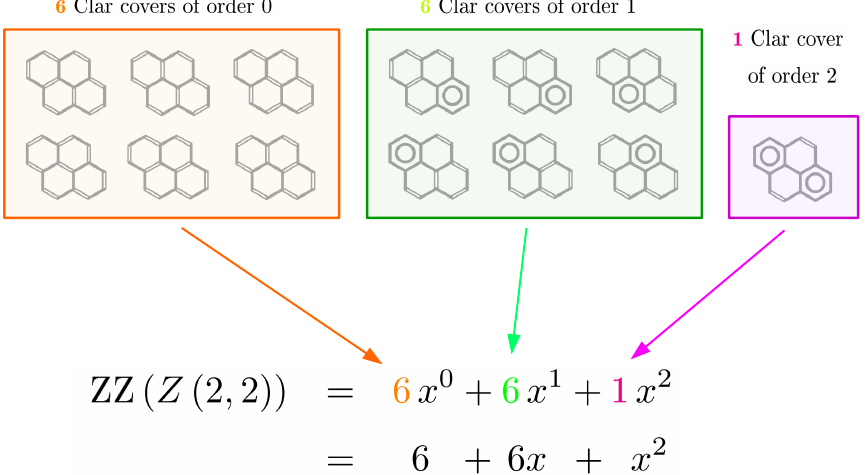
Figure 1. All the 13 conceivable Clar covers of the the multiple zigzag chain Z ( 2,2 ) (i.e., pyrene) can be divided into three classes: (i) Clar covers of order 0 (depicted in the orange frame and usually referred to as the Kekulé structures of Z ( 2,2 ) ) involve no aromatic rings, (ii) Clar covers of order 1 (depicted in the green frame) involve one aromatic ring, and (iii) Clar covers of order 2 (depicted in the magenta frame) involve two aromatic rings. The associated ZZ polynomial of Z ( 2,2 ) , denoted as ZZ ( Z ( m , n ) , x ) , enumerates the number of Clar covers in each class, with the coefficient of each monomial equal to the number of Clar covers in a given class and the power of the monomial equal to the order of a given